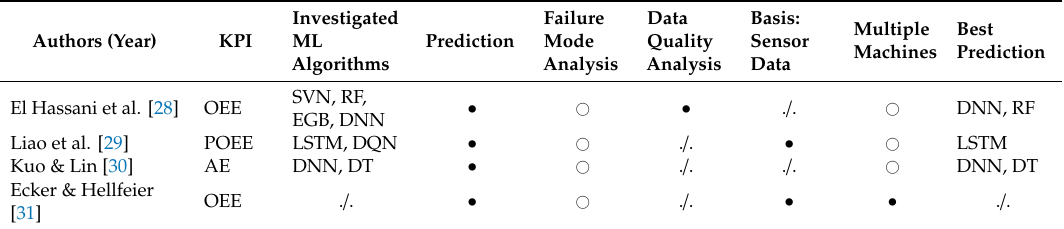
Table 9. Studies on Machine Learning for OEE prediction.